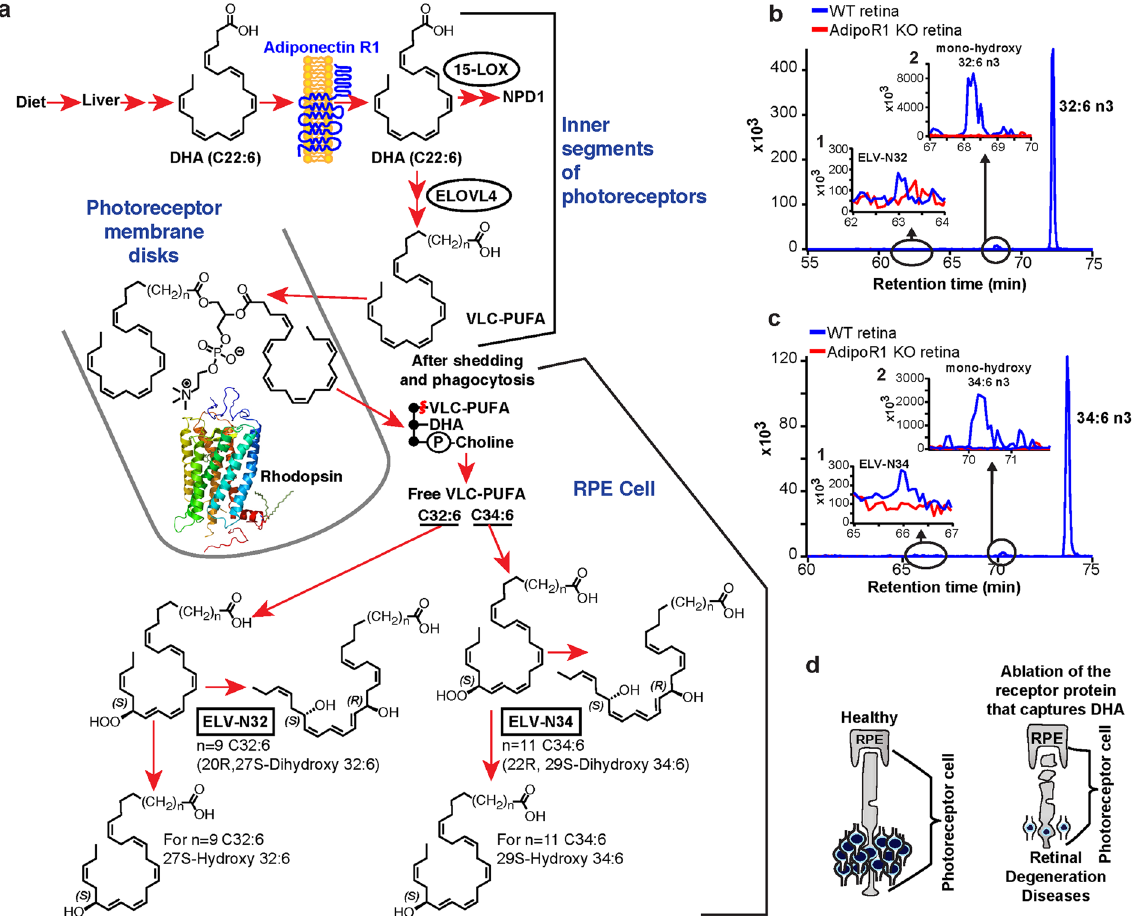
Figure 7. Genetic ablation of adiponectin receptor 1 leads to depletion of VLC-PUFAs and its derivatives in retina. ( a ) Dietary DHA, or that derived from dietary 18:3n3, is supplied by the liver and captured by adiponectin receptor 1 (AdipoR1), followed by elongation in the inner segment of PRC by ELOVL4 to VLC- PUFA and incorporation into phosphatidylcholine molecular species, which also contains DHA. During daily PRC outer segment renewal, these phosphatidylcholine molecular species interact with rhodopsin and, after shedding and phagocytosis, become part of RPE cells. UOS or other disruptors of homeostasis trigger the release of VLC-PUFAs. 32:6n3 and 34:6n3 are depicted generating hydroperoxy forms, and then ELV-N32 or ELV-N34, respectively. ( b) The pool size of free 32:6n3 in retinas of AdipoR1 knockout (KO) mice (red) is decreased as compared with that in wild type (WT) (blue). Insert ( 1 ) shows ELV-N32 in KO (red) and WT (blue); insert ( 2 ) shows mono-hydroxy 32:6n3, the stable derivative of the hydroperoxy precursor of ELV-N32, in WT (blue) and lack of detectable signal in the KO (red). (c) Similarly, the pool size of free 34:6n3 in retinas of AdipoR1 KO mice (red) is decreased as compared with that in WT (blue). Insert ( 1 ) shows ELV-N32 in KO (red) and WT (blue); insert ( 2 ) shows mono-hydroxy 34:6n3, the stable derivative of the hydroperoxy precursor of ELV-N34, in WT (blue) and lack of detectable signal in the KO (red). (d ) RPE cells sustain PRC functional integrity (left); right, the ablation of AdipoR1 switches off DHA availability, and PRC degeneration